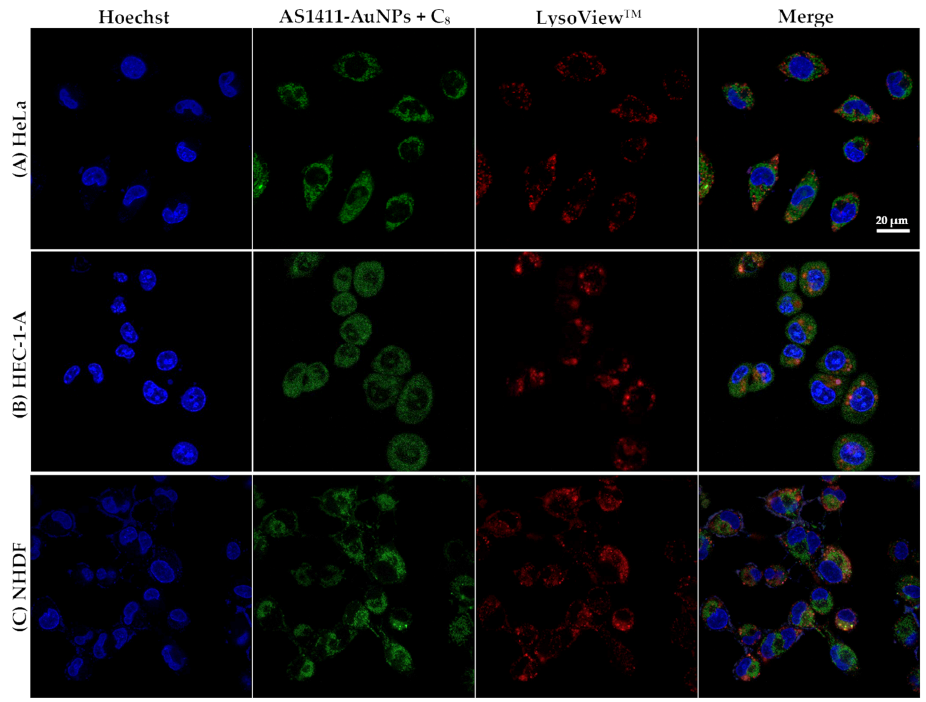
Figure 4 . Confocal fluorescence images of ( A ) HeLa, ( B ) HEC-1-A, and ( C ) NHDF cell lines incubated with AS1411-gold nanoparticles with IQ (AS1411-AuNPs + IQ; green) for 2 h at 37 °C. Lysosomes are stained with LysoViewTM shown in red. Cell nuclei are stained with Hoechst 33342 (blue). Scale bar: 20 µm.